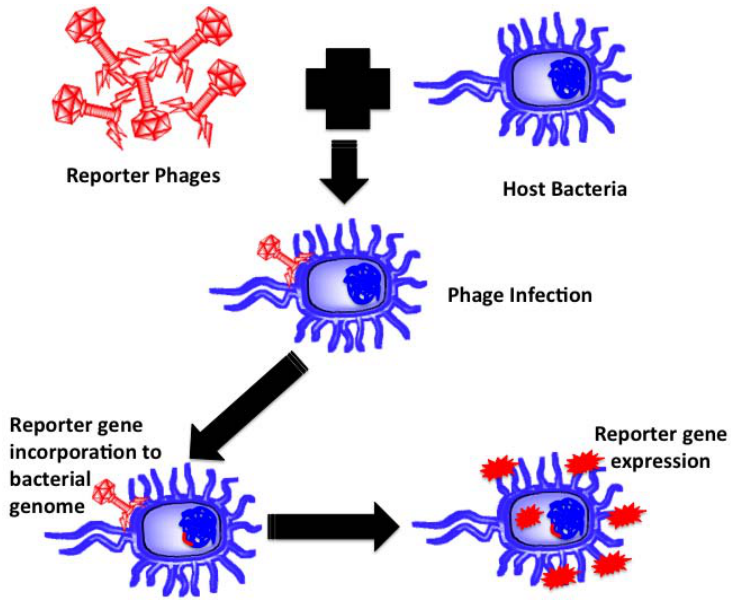
Figure 4. A schematic explaining the underlying principle of reporter phage-based detection of a pathogen of